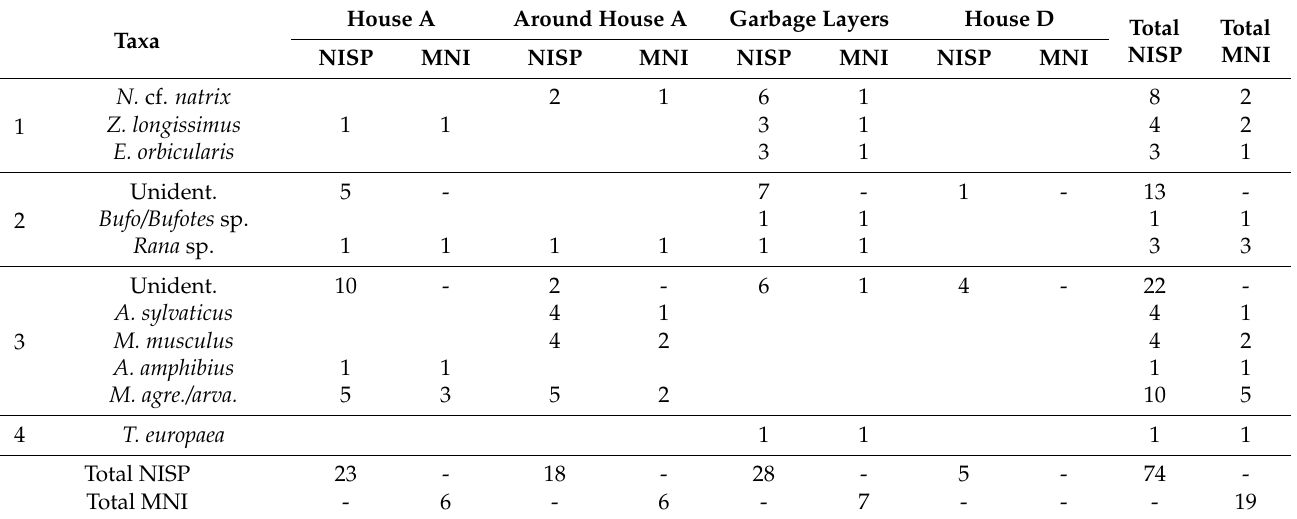
Table 3. Identified microvertebrate taxa from the studied layers in Borsodiv á nka from the 2020 cam- paign. NISP: number of identified specimens; MNI: minimum number of individuals. 1, Squamata; 2, Anura; 3, Rodentia; 4,